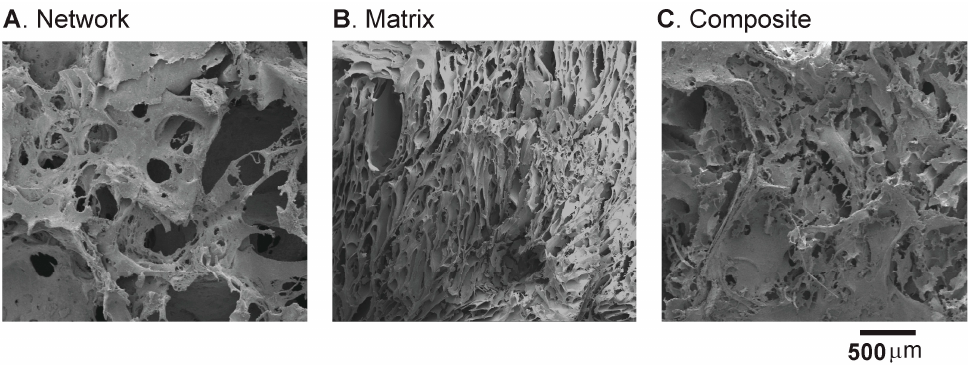
Figure 6. Scanning electron microscope (SEM) micrographs show microstructural differences. ( A )